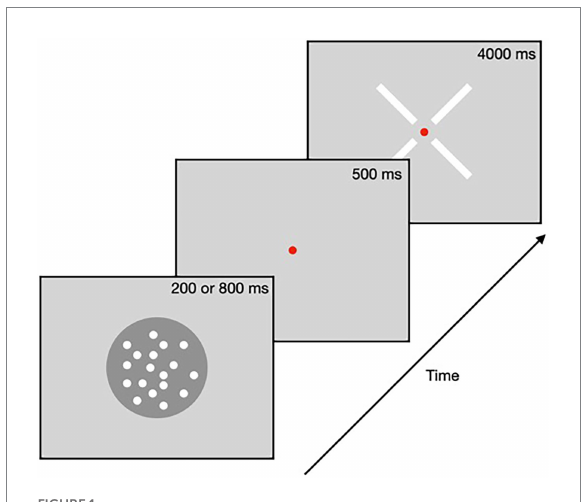
FIGURE 1 Task procedure. Random dot motion stimuli were presented for one of two Durations (either 200 ms or 800 ms) followed by a delay period of 500 ms, and then a response cross appeared, which participants clicked to register the perceived direction of